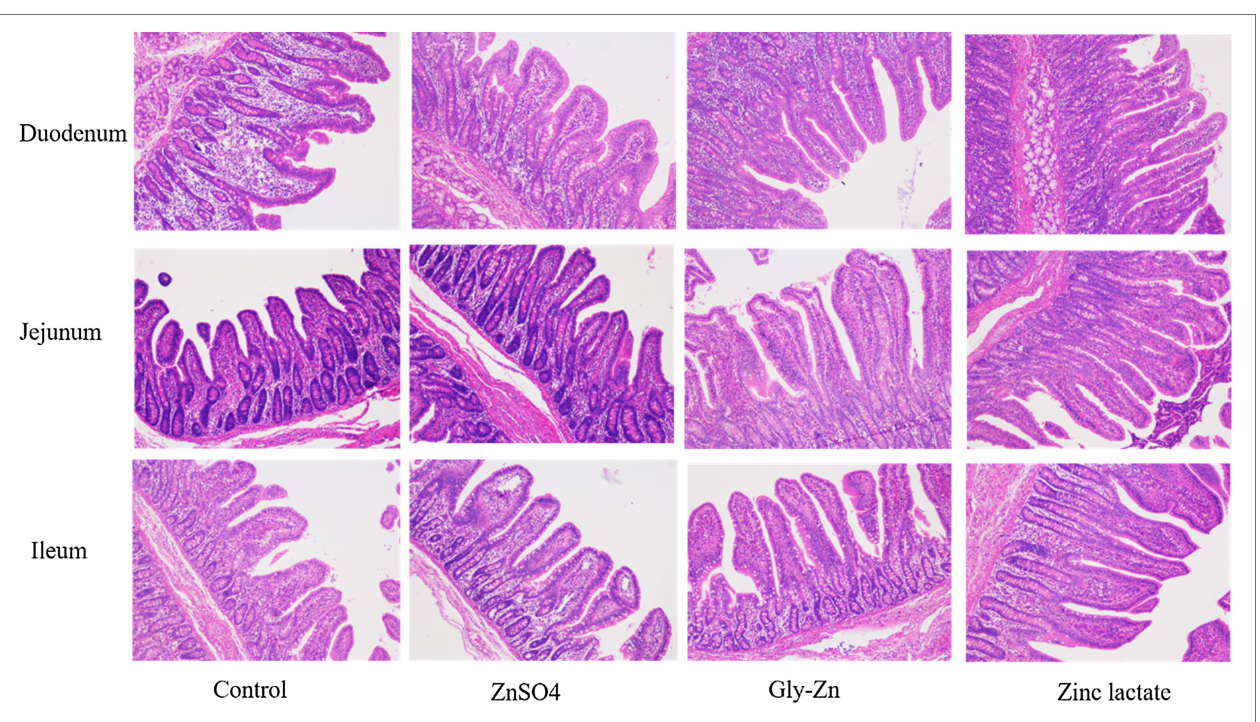
FIGURE 2 | Effect of dietary zinc sources on intestinal morphology (images) in weaned piglets. Control, basal diet. ZnSO4, basal diet +100 mg/kg zinc sulphate. Gly-Zn, basal diet +100 mg/kg glycine zinc. Zinc lactate, basal diet +100 mg/kg zinc lactate.